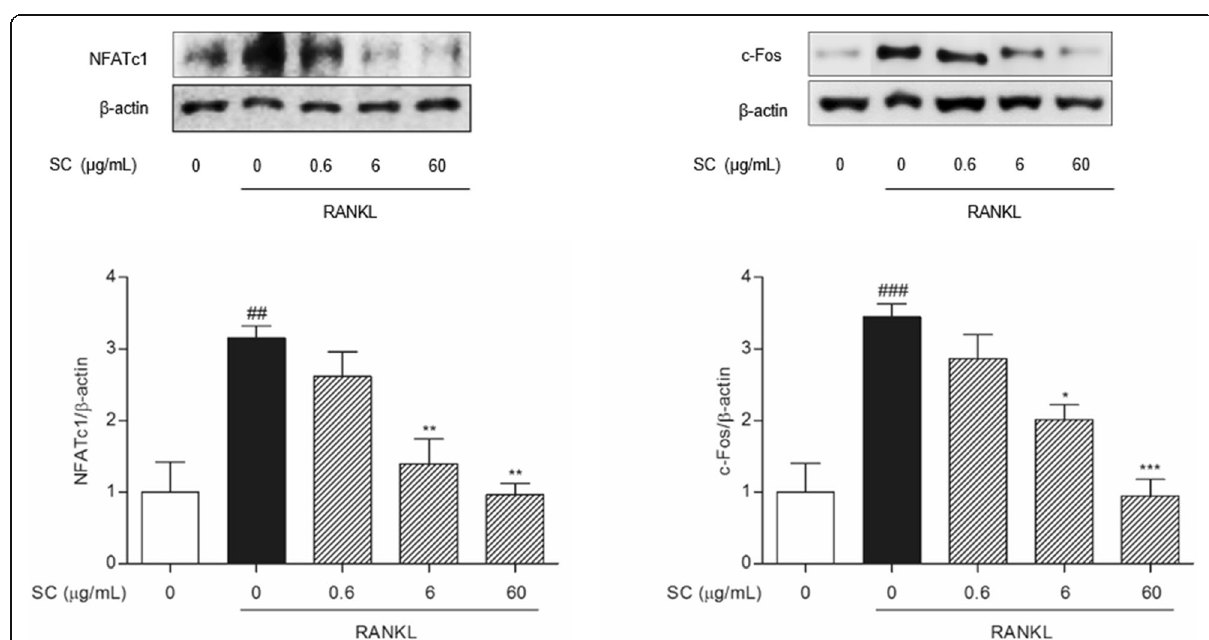
Fig. 5 The effects of SC on NFATc1 and c-fos protein expressions in RANKL-stimulated RAW 264.7 cells. RAW 264.7 cells were cultured in the presence of RANKL with the vehicle or SC. After 7 days, total protein was then isolated and protein expression levels were evaluated by Western blot assay. Data are represented as the means ± S.E.M. of three independent experiments. ## p <0.01 and ### p <0.001 compared with non-treated cells. * p <0.05, ** p <0.01 and *** p <0.001 compared with only RANKL-treated